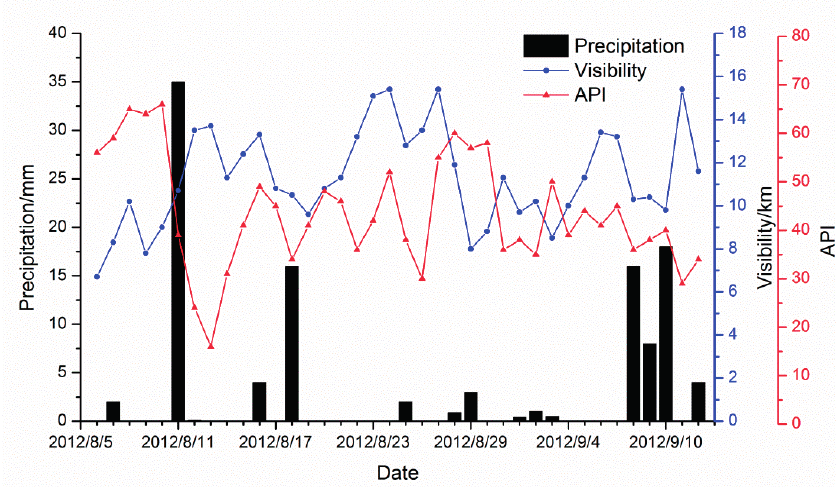
Figure 3. Daily variations in visibility, API and precipitation during the sampling period in